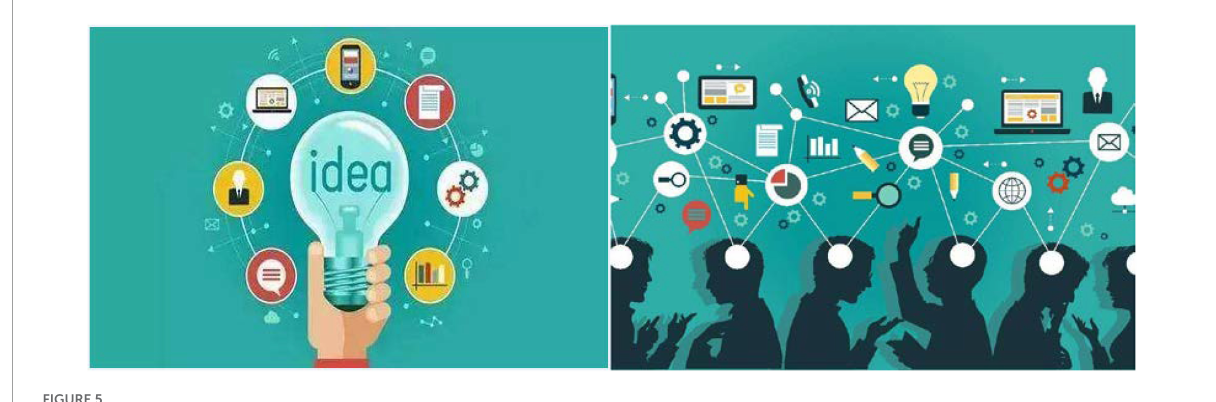
FIGURE5 Demonstration of innovation and entrepreneurship